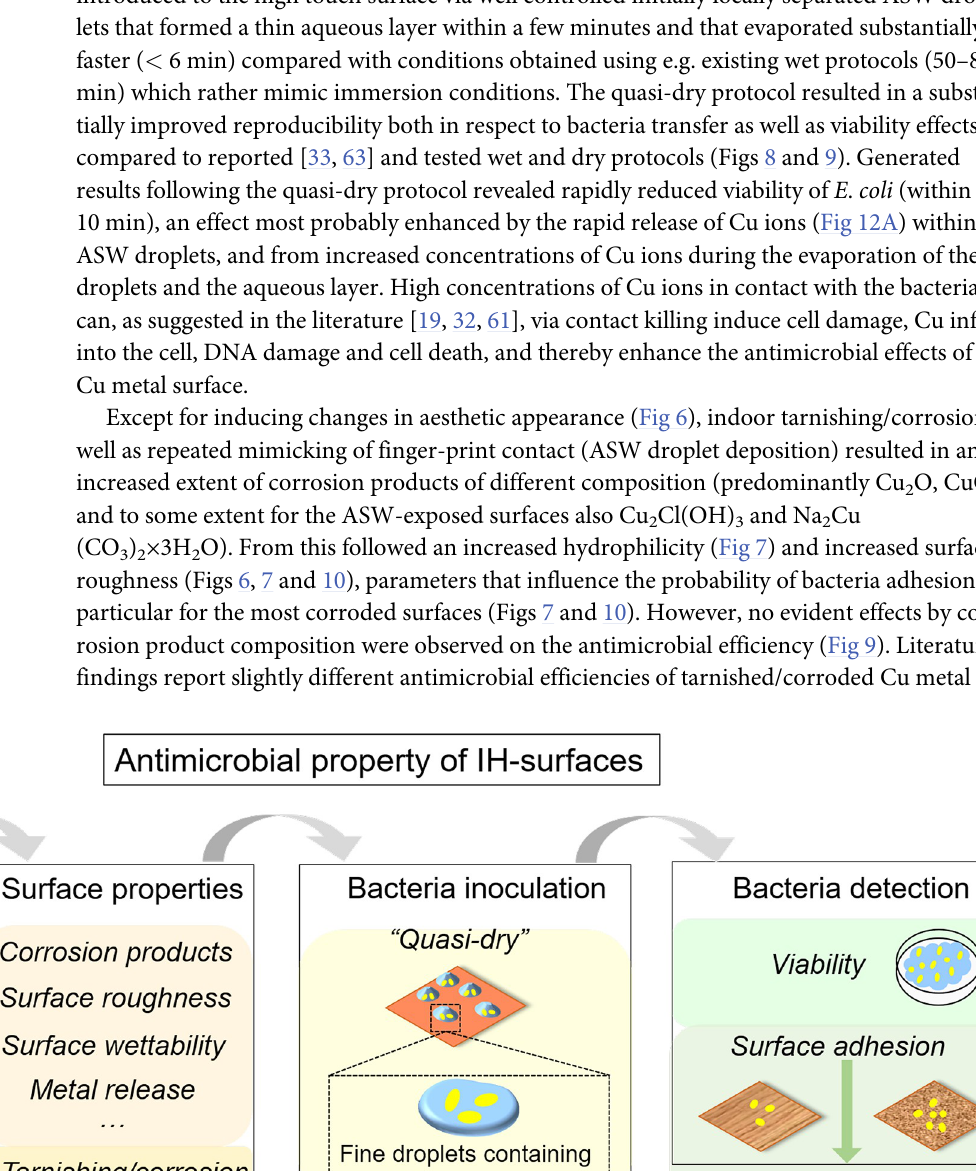
Fig 12. Released amounts of Cu in deposited ASW droplets (following the quasi-dry protocol) after 10 min of exposure of one-day aged (tarnished/corroded) surfaces both with and without the presence of E. coli (a); bacterial survival (p = 0.04 < 0.05) of E. Coli (OD 600 = 1) after 10 min of exposure in ASW solution at different Cu 2+ concentrations (b).